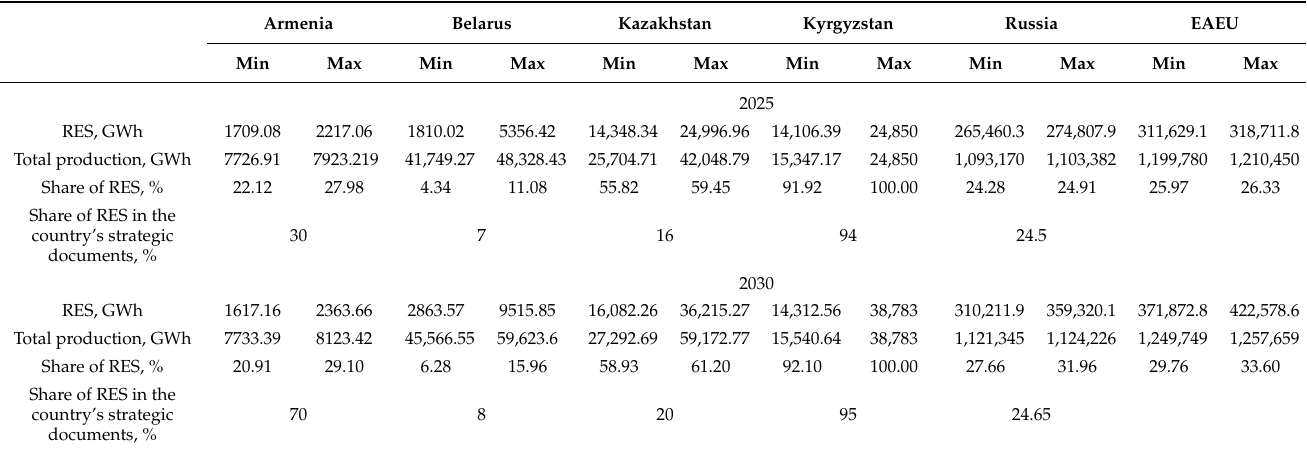
Table 9. Forecast of energy generation and the share of RES in total